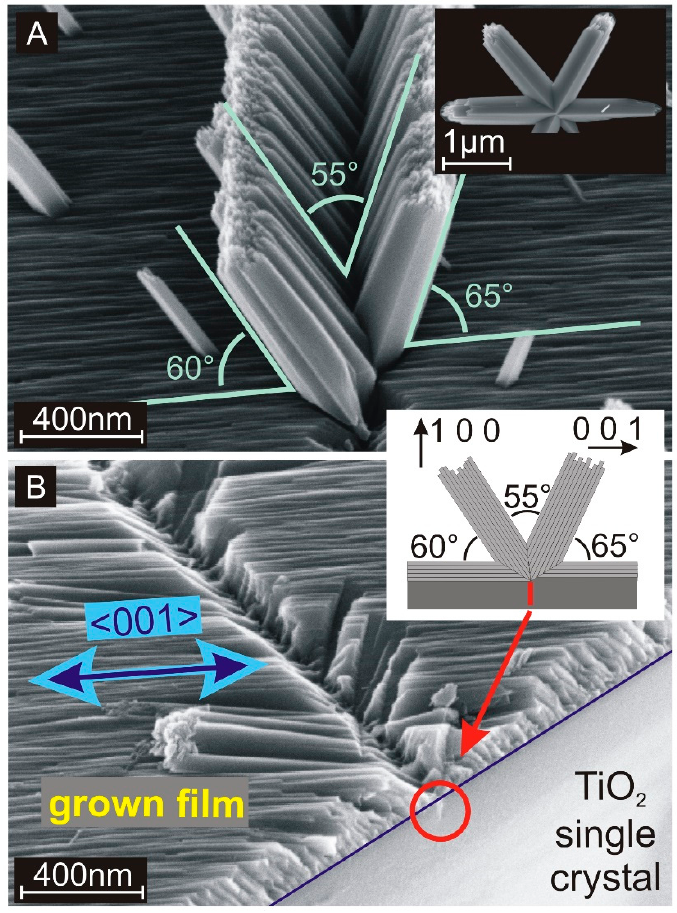
Figure 2. ( A ) Scanning electron microscope (SEM) cross-section image of an extended branching site on a {100} single rutile crystal. The inset shows an individual branched nanorod, which was created in the solution in the absence of any macroscopic seed substrate. ( B ) SEM cross-section image of an extended branching row, where the branches were removed with sonication. The blue line marks the interface between the single-crystalline rutile TiO 2 {001} substrate and the grown TiO 2 layer. The red cycle marks a rupture inside the substrate that is supposed to be the origin of the branching. The principal growth direction ([001]) is marked with a blue arrow. Inset: Schematic drawing of the hydrothermal growth on {100} single crystals including a double branching event resulting in expanded nanorod walls.